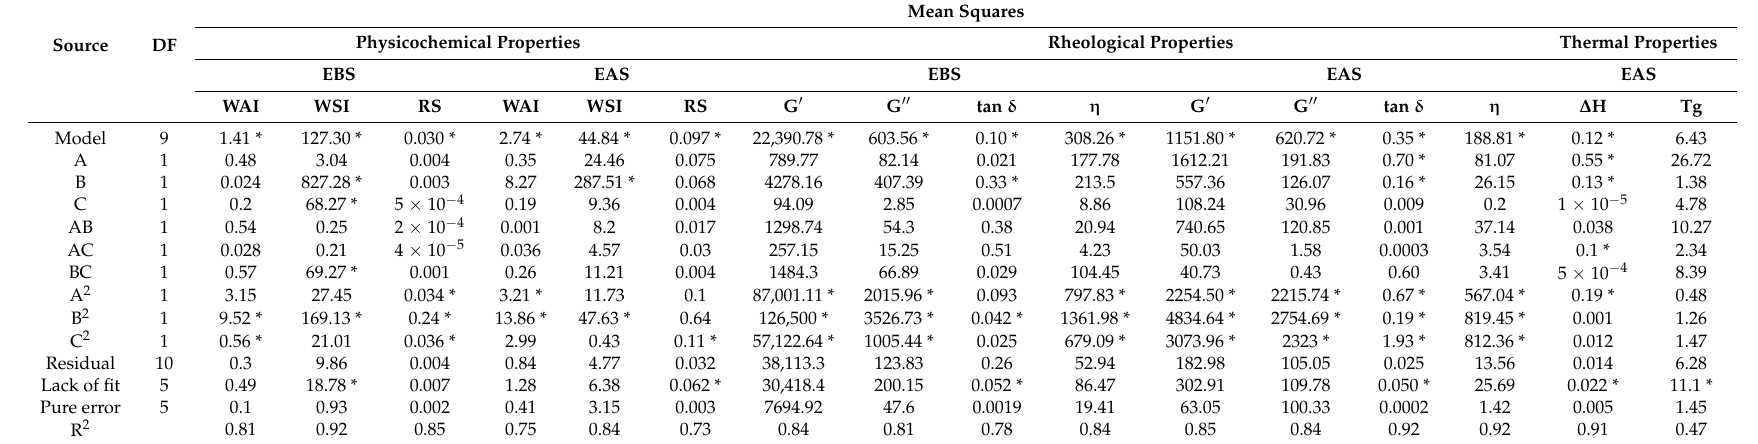
Table 4. Analysis of variance of physicochemical properties of cornstarch extruded at different condition